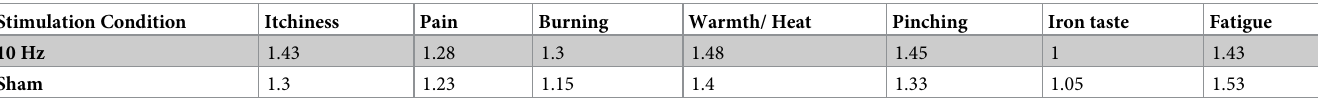
Table 2. Average intensity of the sensations felt during the experiment as reported by participants on a scale from 1 (no sensations) to 5 (strong sensations). Stimulation Condition